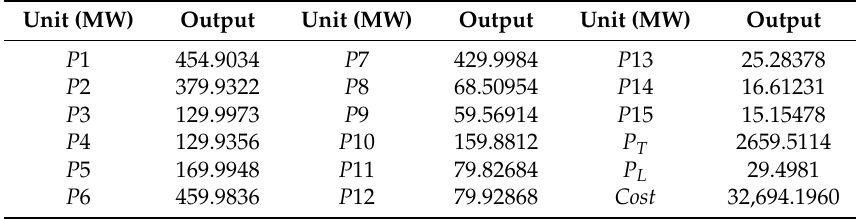
Table 12. Best solution achieved by ML-CLPSO-AM on 15 units system.